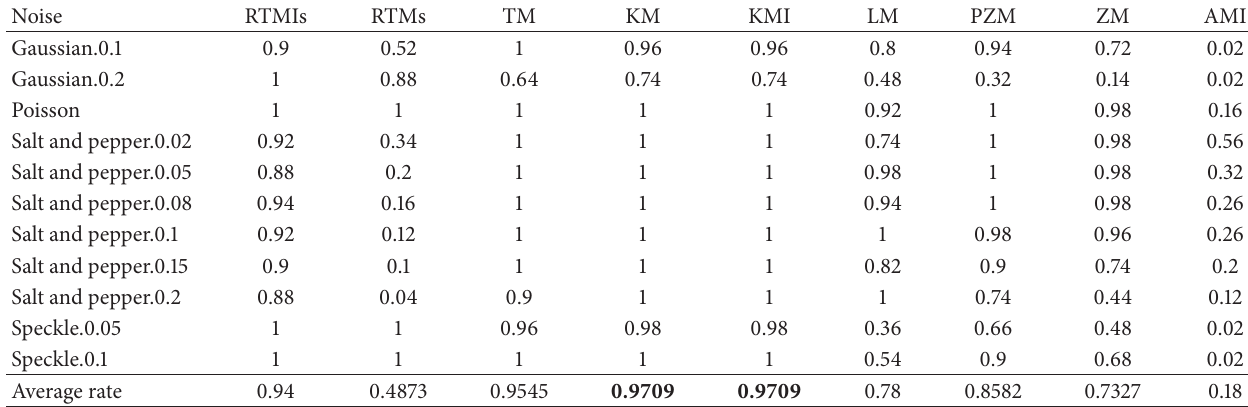
Table 1: Recognition rates of different moments about logos with different